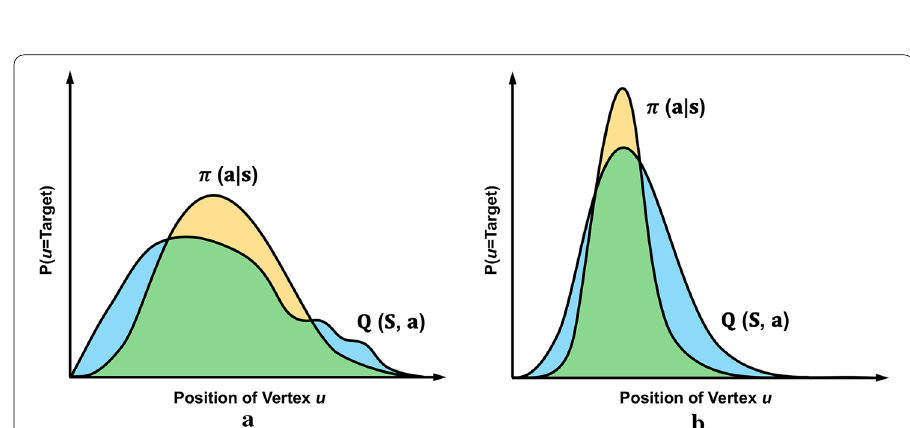
Fig. 7 Illustration of how quality of node embedding affects the quality of policy and reward functions; a highly uncertain reward and policy functions, b highly concentrated reward and policy functions. Ideally, our policy is distributed around the best action with minimal variance, so b is